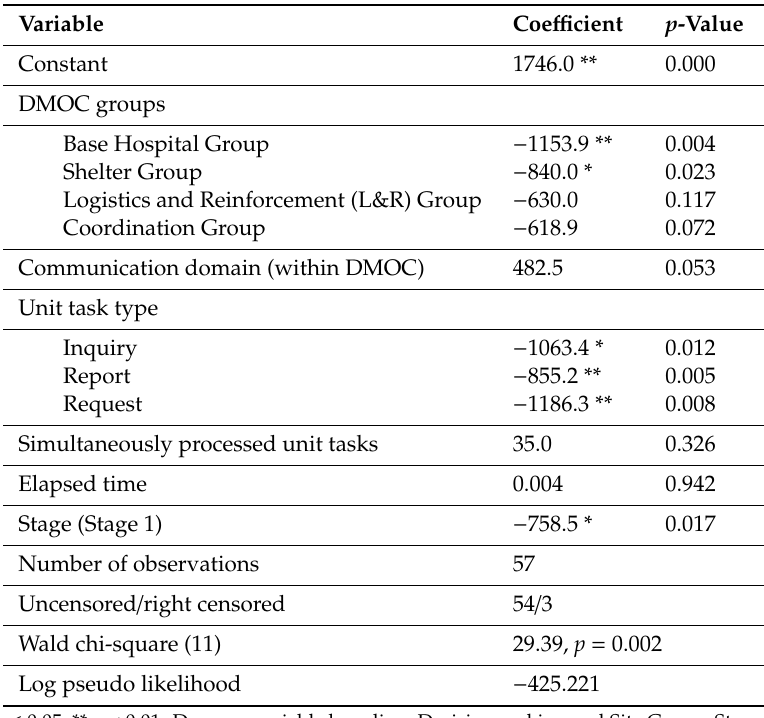
Table 3. Censored regression analysis for October